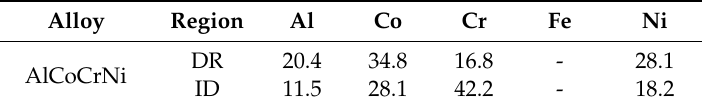
Table 1. Average area composition (in at.%) of dendrite (DR) and interdendrite (ID) regions of the AlCoCrNi (w/o Fe) alloy, as analyzed by energy dispersive spectrometry (EDS) in scanning electron microscope (SEM). Standard deviation of the measurements was significantly smaller than expected standard-less EDS accuracy.